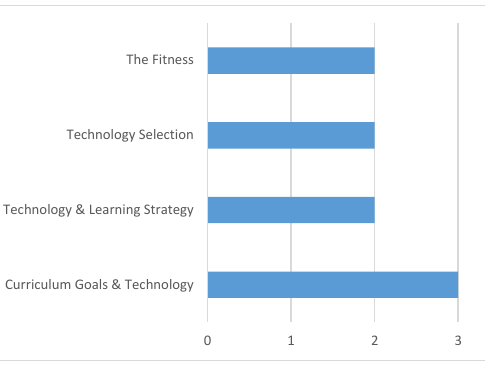
Figure 4: Mode value from lesson plan analysis’ results